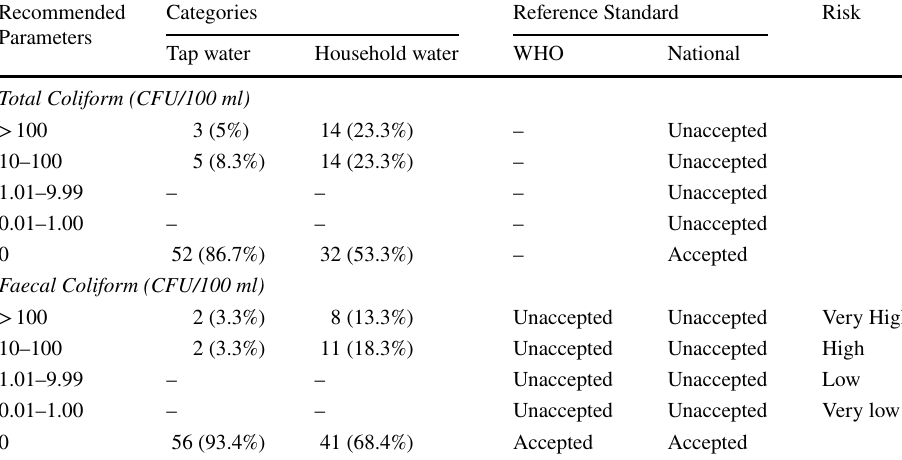
* Significant at p < 0.05, **Significant at p < Table 3 Comparison of bacteriological quality of water samples collected from taps and households with WHO recommended values, Hawassa,